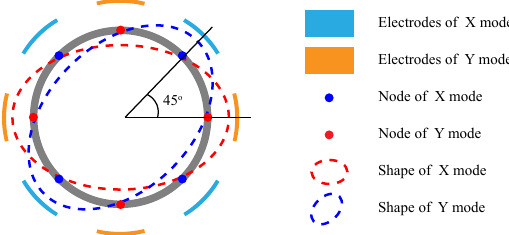
Figure 1. The vibratory mode of one ideal ring resonator ( n = 2).